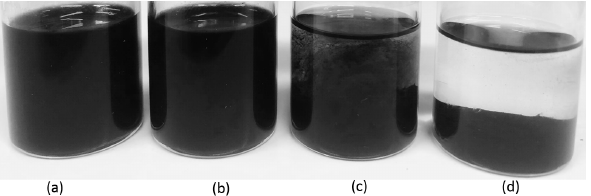
Figure 7. fMWCNT/solvent dispersion after 7 days: ( a ) Water; ( b ) Ethanol; ( c ) 2-propanol; ( d ) Toluene.